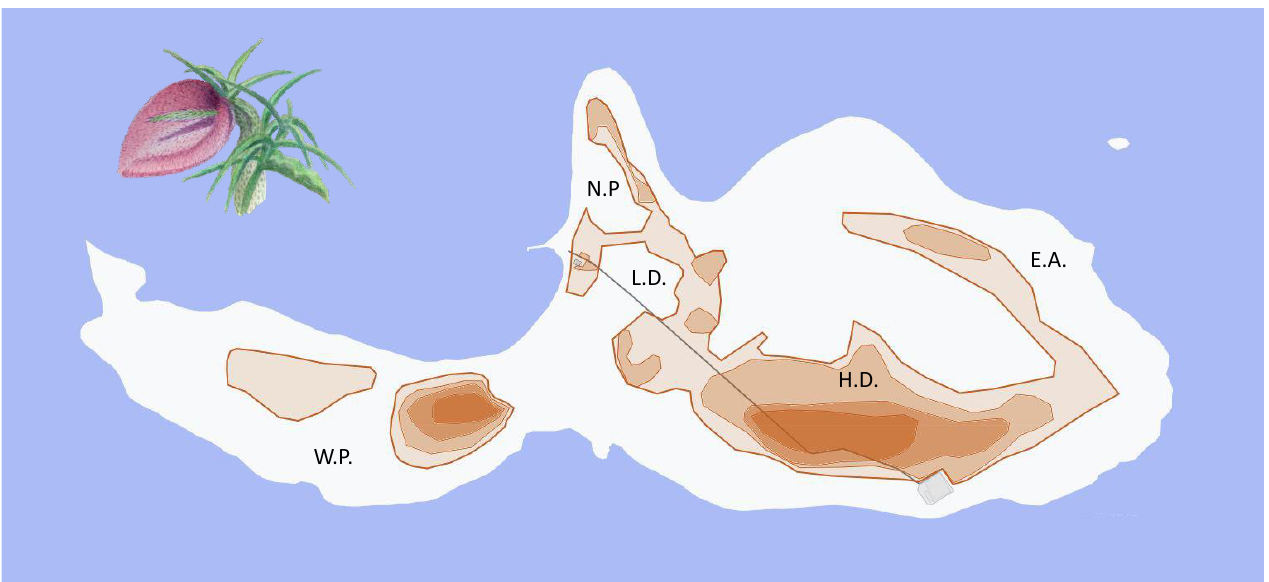
Figure 2. Distribution and densities of Helicodiceros muscivorus on Aire Island. This distribution is based upon data from 2021 and 2022.